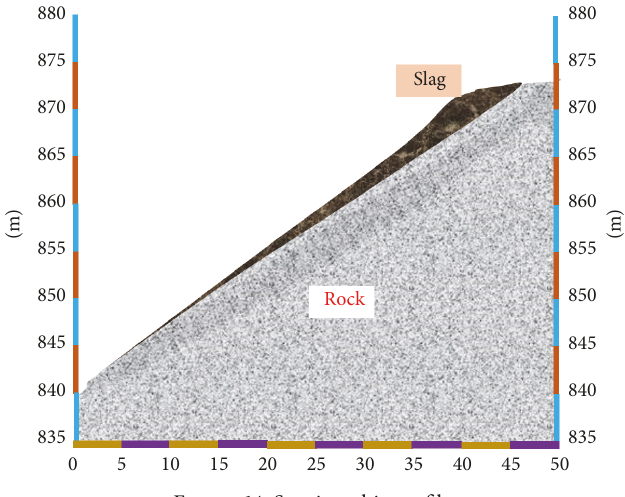
Figure 14: Stratigraphic profile.